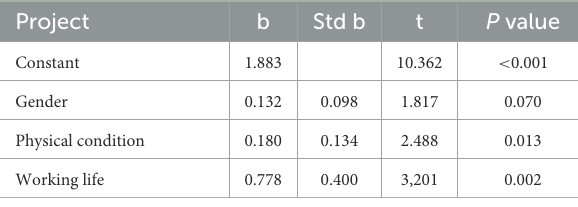
TABLE 6 Results of multiple linear regression of personal accomplishment.